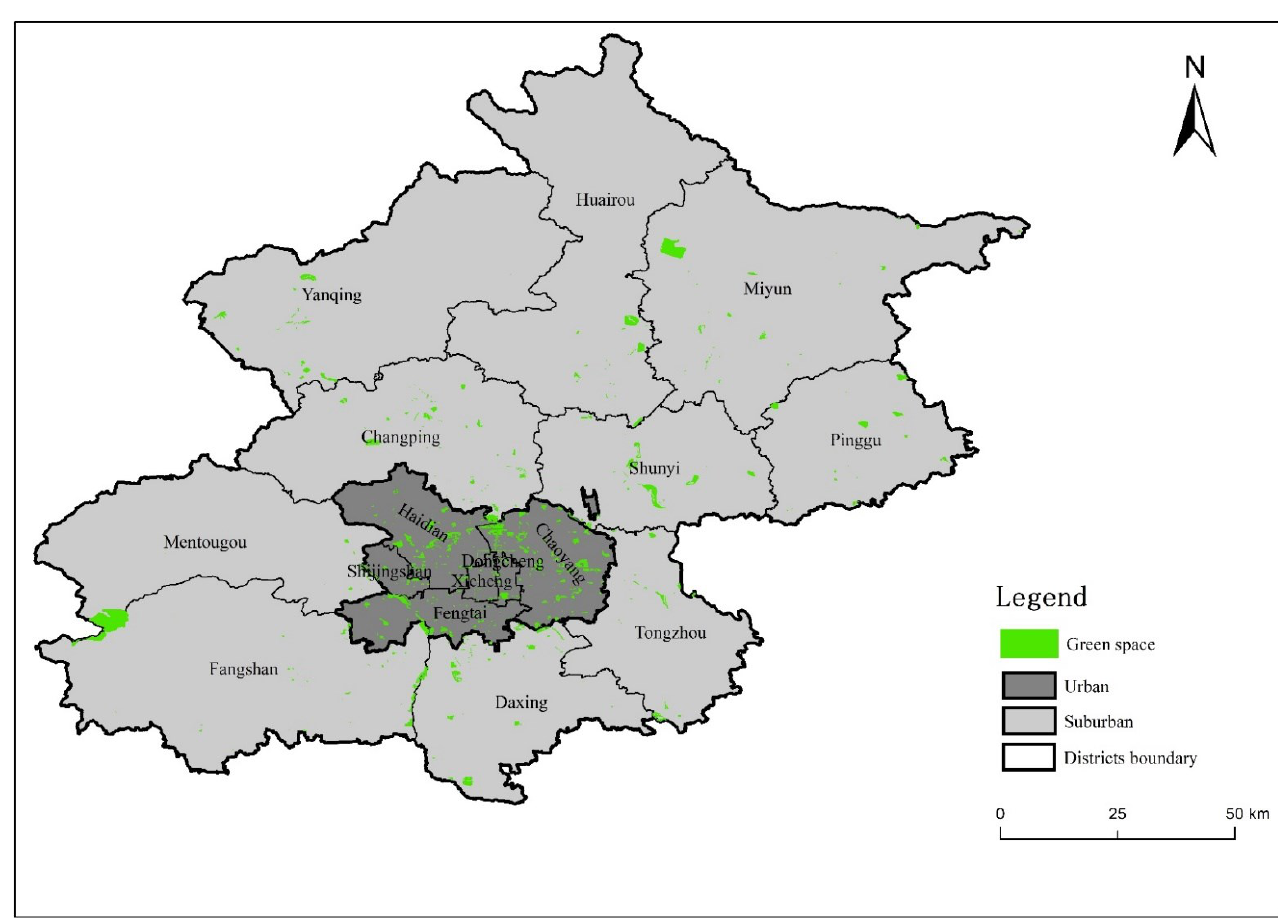
Figure 1. The distribution of main public urban green spaces in Beijing’s urban and suburban districts. Table 1. Classification of UGS’ social benefits into two main categories in the questionnaire